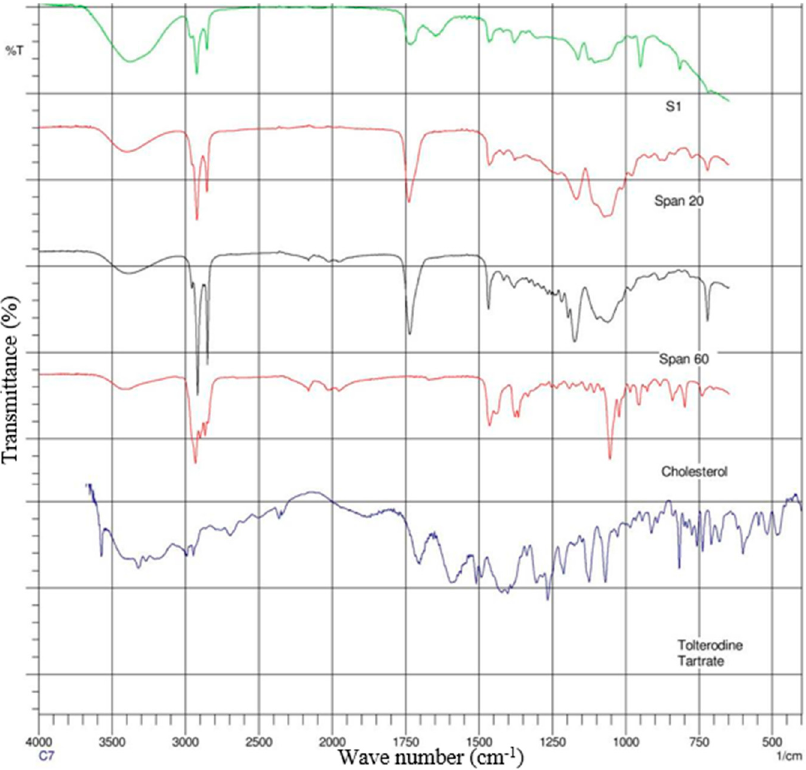
Figure 3. Attenuated total reflectance Fourier transform infrared (ATR-FTIR) spectra of formulation (S1) and its individual components.